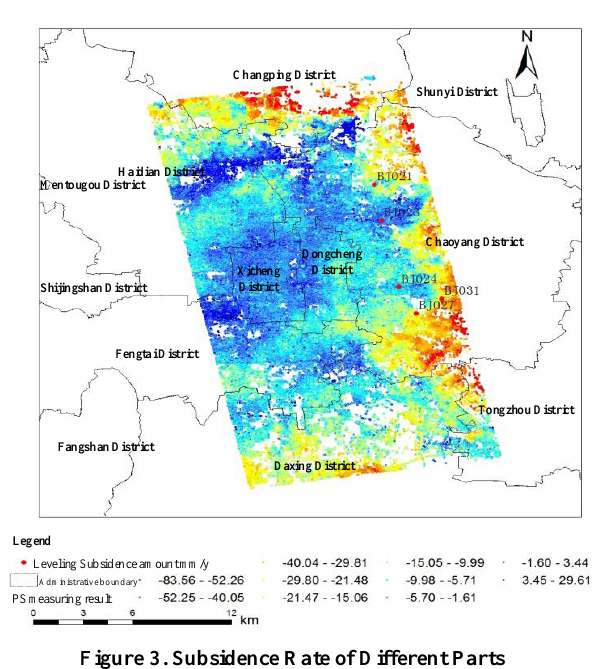
Figure 3. Subsidence Rate of Different Parts